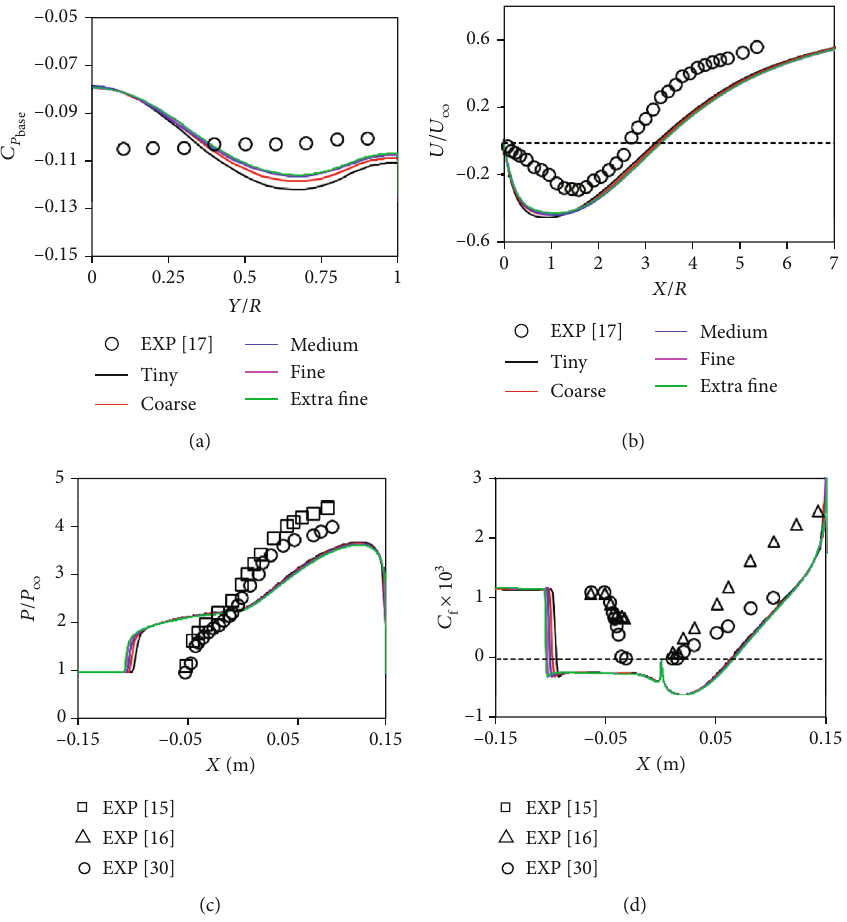
Figure 4: Grid sensitivity tests for the (a, b) axisymmetric base and (c, d) 24-deg compression ramp.